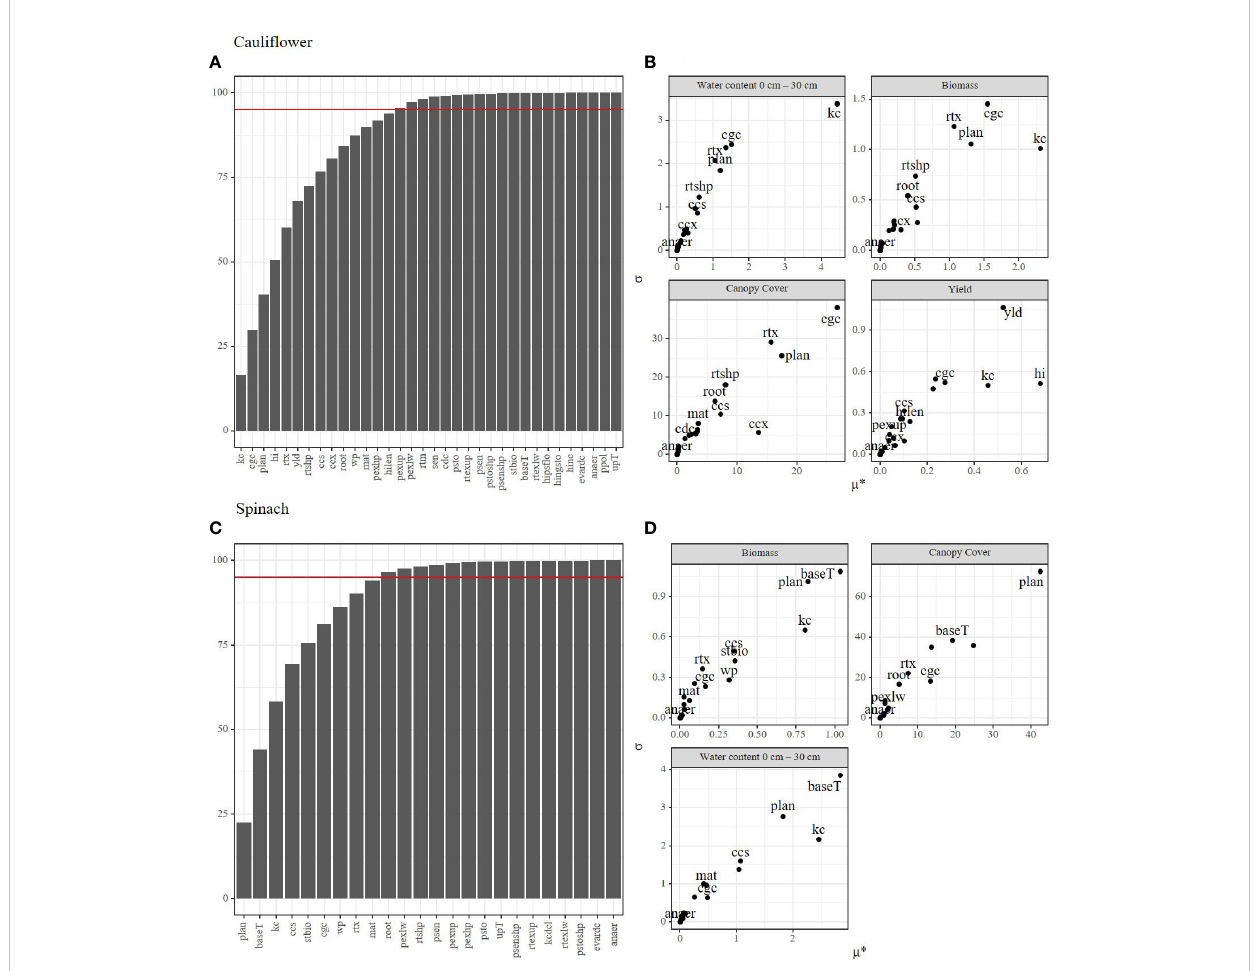
FIGURE 2 Morris method applied for the spinach and cauli fl ower fi elds under study for determining the most in fl uential parameters. Plots (A, B) show the cumulative sensitivity of the parameters on the model outputs ( A for cauli fl ower, B for spinach). The horizontal red line indicates 95 percent of the total sensitivity for determining the most in fl uential parameters to be used in the Bayesian calibration. Plots (C, D) show the sensitivity ( m *) calculated for every output variable separately ( C for cauli fl ower, D for spinach). X-axis indicate the sensitivity of each parameter on the model output, the Y-axis ( s ) indicates interaction and non-linear effects of each